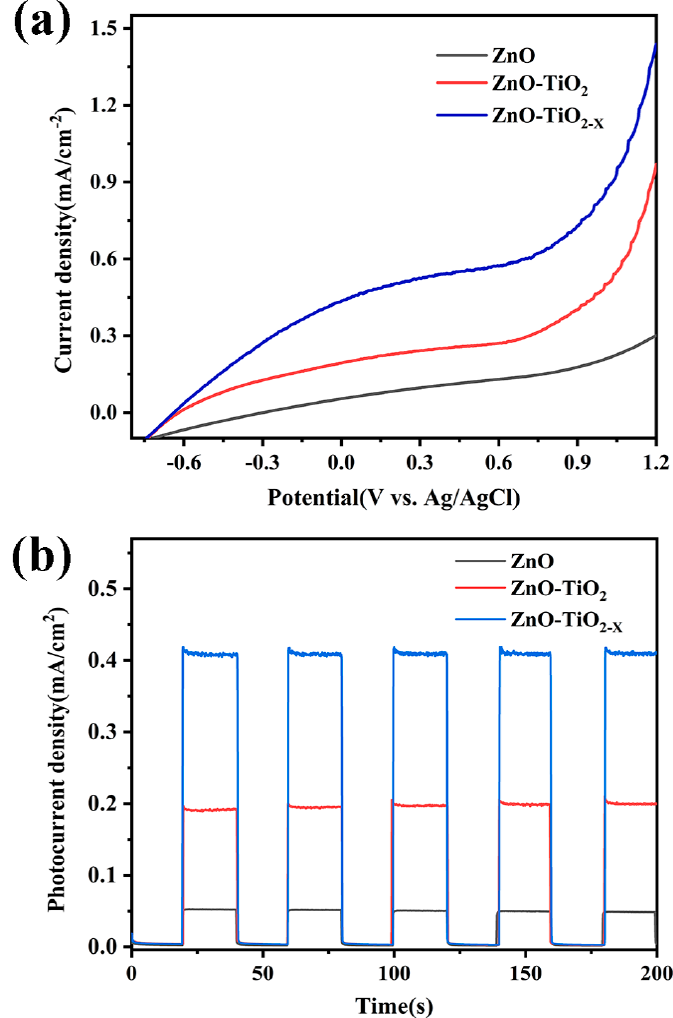
Figure 7. ( a ) Linear sweep voltammetry (LSV) characteristics and ( b ) photocurrent responses of pure ZnO, ZnO/TiO 2 , ZnO/TiO 2-X homojunction with on/off radiation in a 1 M KOH solution under AM 1.5.